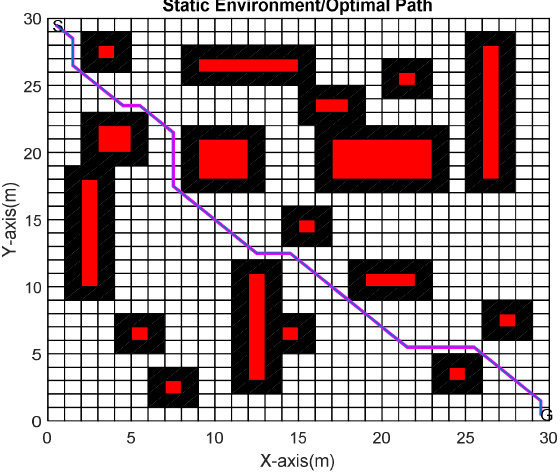
Fig. 24. Best Path found by Modified ACO for Experiment